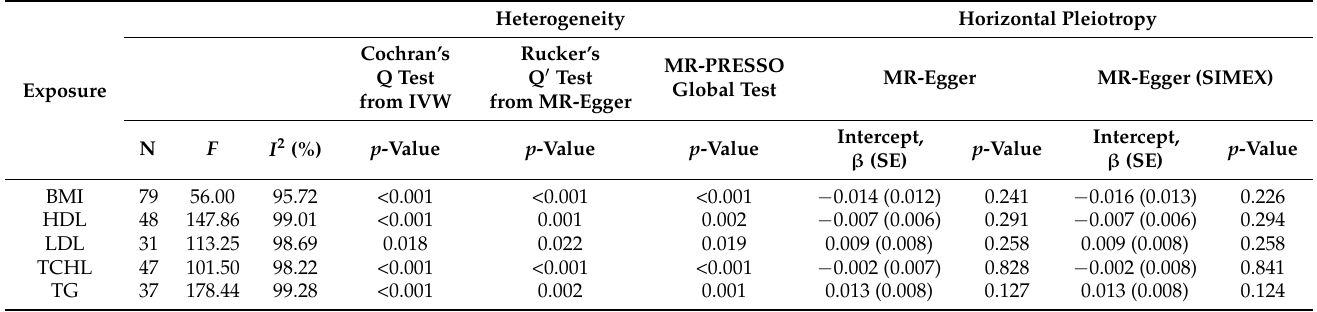
Table 2. Heterogeneity and horizontal pleiotropy of instrumental